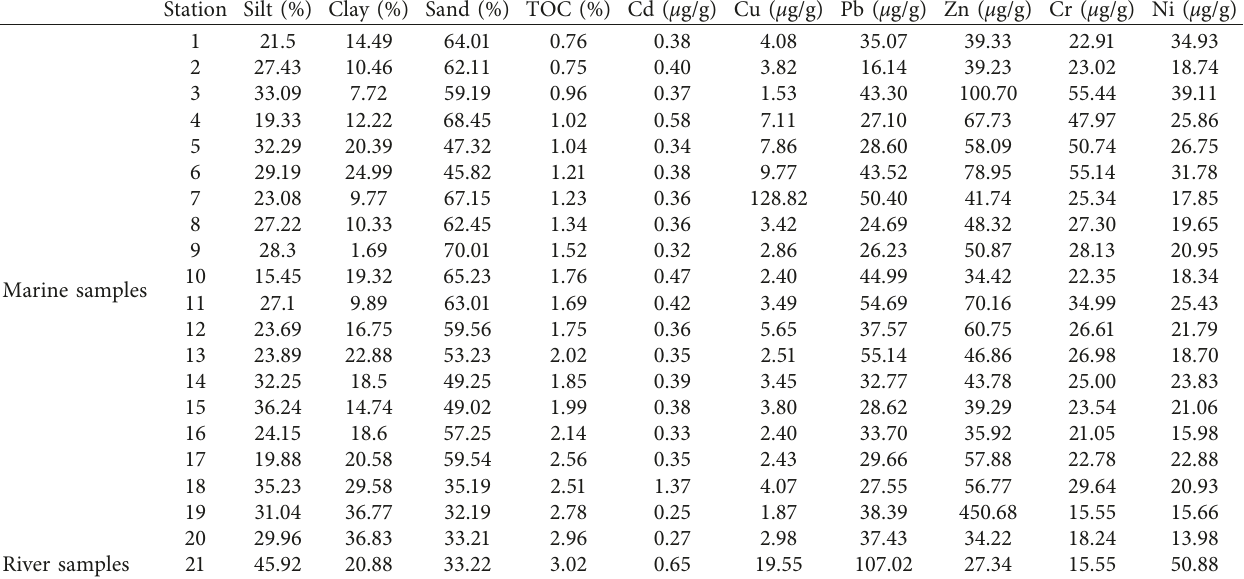
Table 4: Textural parameters and total heavy metals for surface sediments of the Rades-Hamam Lif coast.